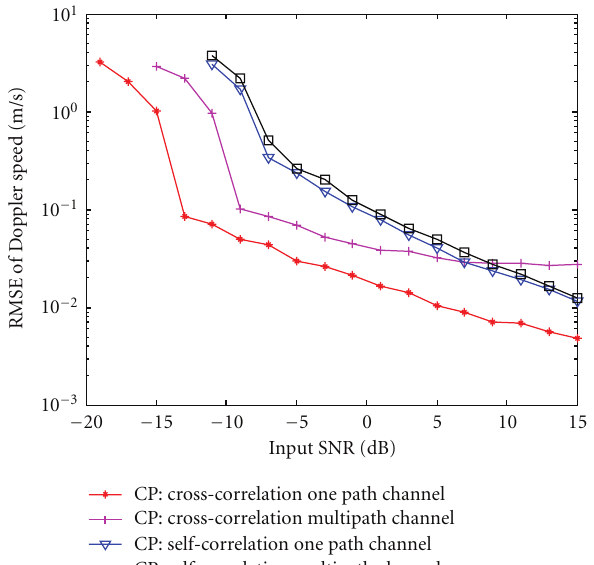
Figure 3: Performance of di ff erent estimators for the CP-OFDM preamble in single-path and multipath channels (channel settings 1 and 2).